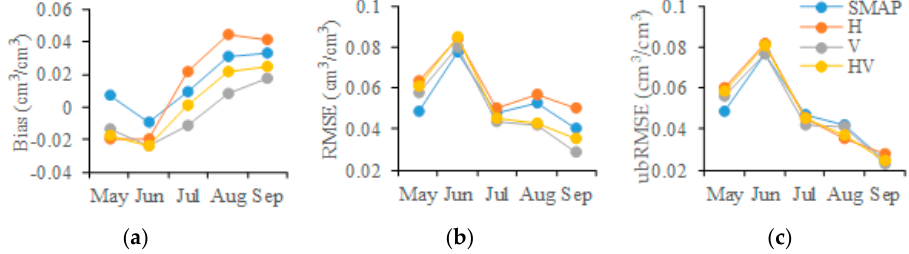
Figure 11. Change in average monthly bias, RMSE and ubRMSE of estimated SSM for four algorithms with time, based on the SMAP ascending brightness temperature from 2016–2018.